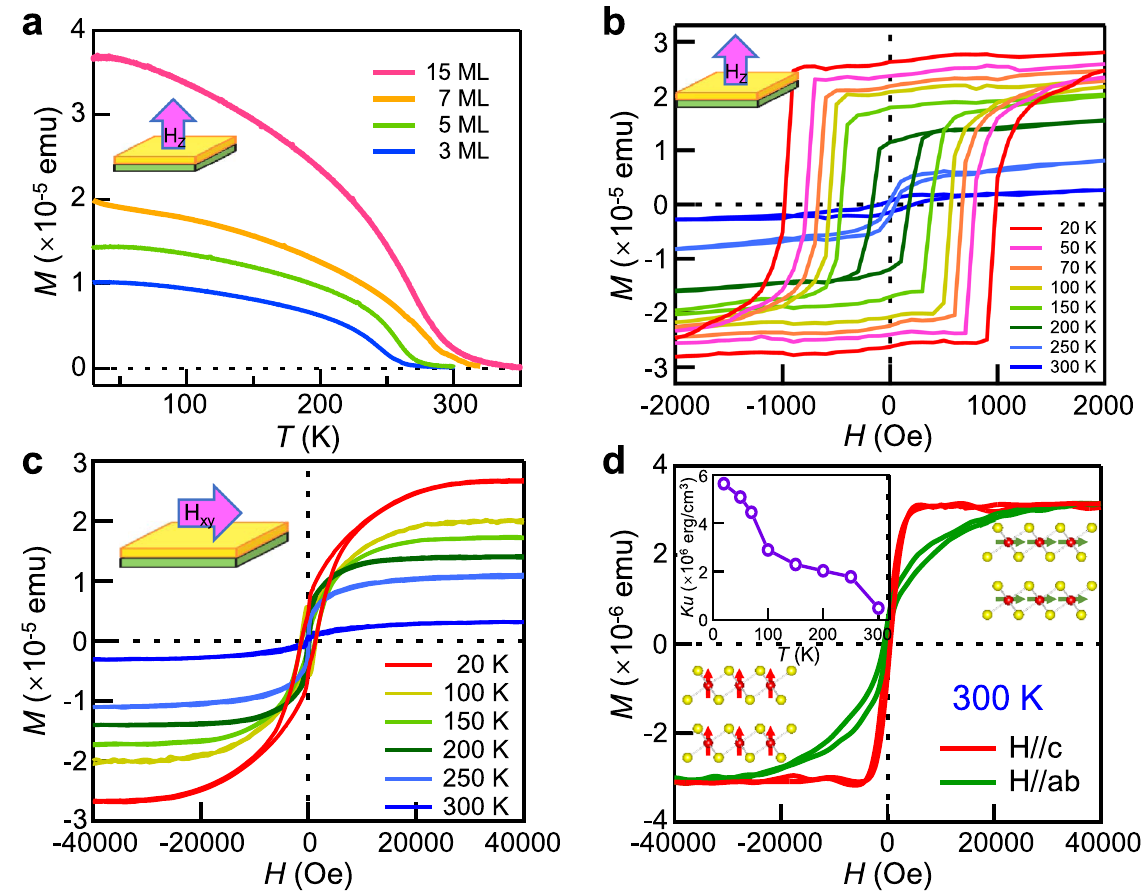
Fig. 2 SQUID measurements of the CrTe 2 fi lms. a Temperature dependent magnetization curves of the fi lms with various thicknesses under fi eld-cooled mode. The magnetic fi eld is applied along the out-of-plane direction with a magnitude of 1000 Oe. The high T C is preserved with thickness decreasing to 3 ML. b , c Magnetic hysteresis loops of 7 ML CrTe 2 at different temperatures with external fi elds along the perpendicular ( b ) and parallel orientation ( c ) with respect to sample plane, indicating a strong out-of-plane magnetic anisotropy. d Enlarged hysteresis loops of 7 ML CrTe 2 at 300 K, where the intrinsic ferromagnetism and PMA still maintains. Top inset: temperature dependence of K u for 7 ML CrTe 2 , where the K u is preserved at 300 K, despite the lower intensity with the increase of